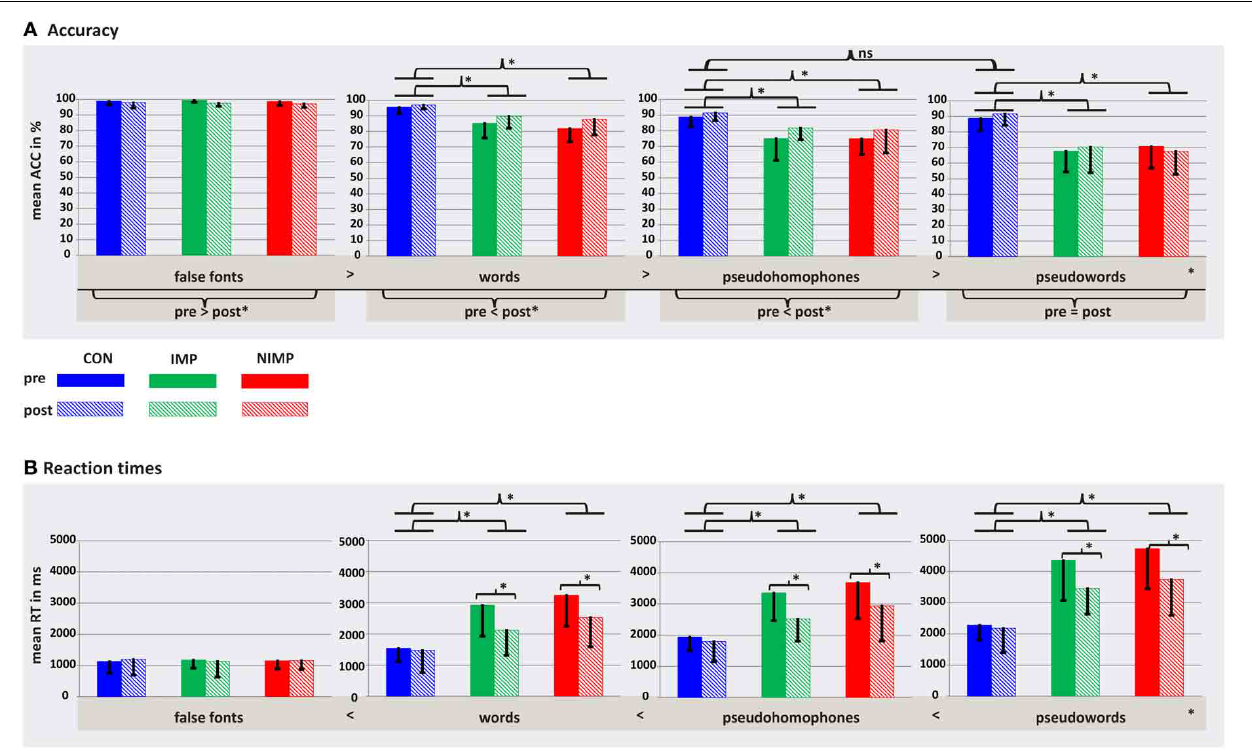
FIGURE 6 | Behavioral results for the PLD—task for control children (CON), improvers (IMP), and non-improvers (NIMP) before (pre) and after (post) intervention. (A) Depicts accuracy data and (B) illustrates reaction time data. Error bars illustrate standard deviation. ∗ p < 0 . 05; ns, non-significant.